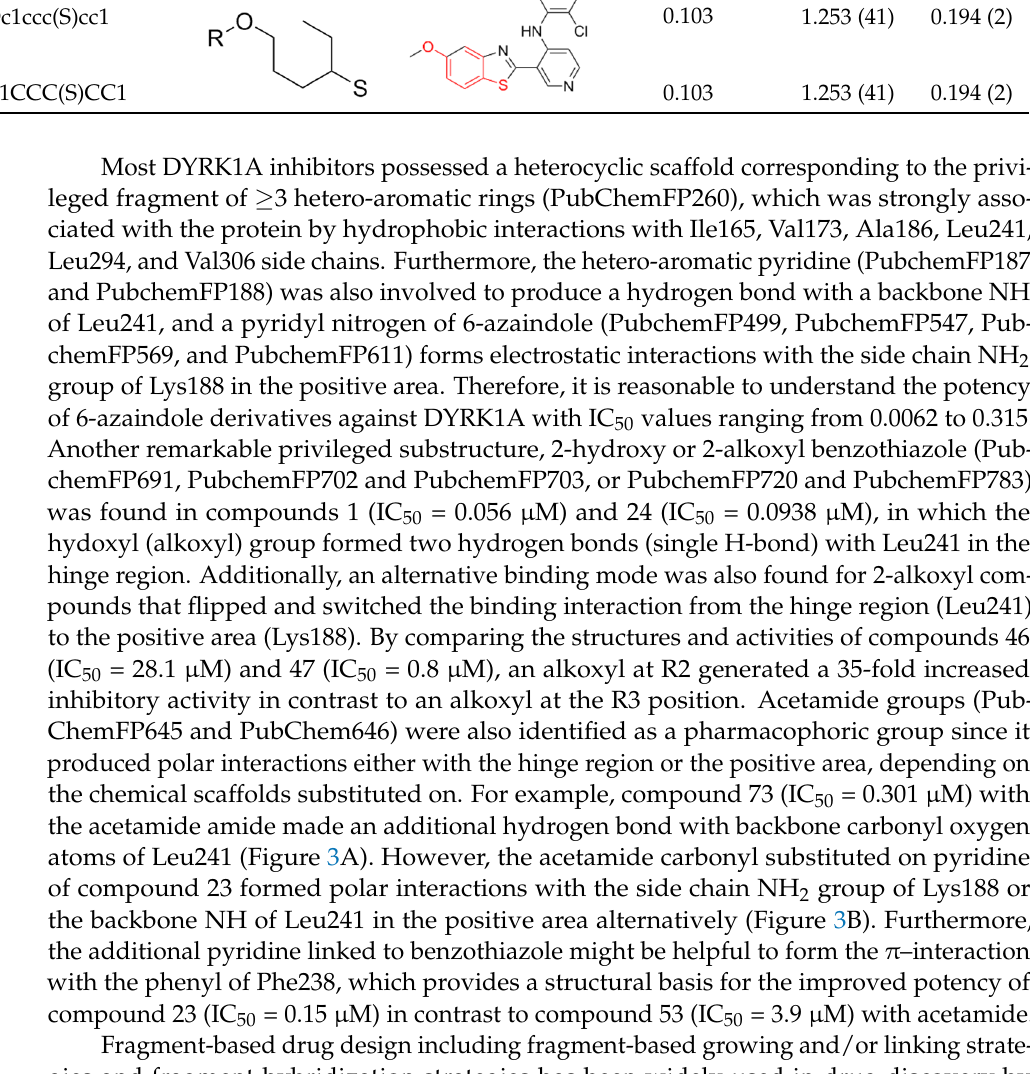
for the acetamide group of CP4 to interact with Lys188. Imidazole (CP111) and isoxazole (CP23) are also expected to form hydrogen bonds with Leu241 and/or Ser242 of the hinge region.